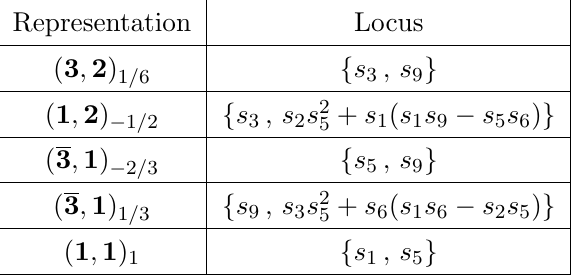
-model, together 11 generator is indicated by Y